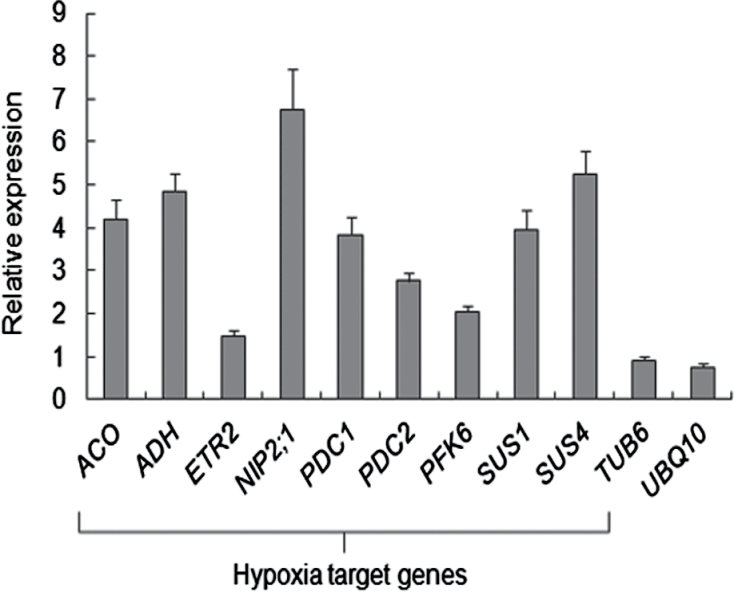
Expression of hypoxic-responsive genes in hyperhydric Arabidopsis seedlings. After 7 d growth on 0.7% agar, seedlings were transferred to fresh 0.7% agar or to 0.2% Gelrite. Total RNA was extracted from complete seedlings 10 d after transfer. Relative expression levels of the indicated hypoxia-target genes were quantified by qRT-PCR and normalized to Act2 levels. As controls, expression levels of the housekeeping genes UBQ10 and TUB6 were assessed. Each value is the mean ±SE of three biological and six technical replicates, and values are presented as expression fold change (Gelrite versus agar).